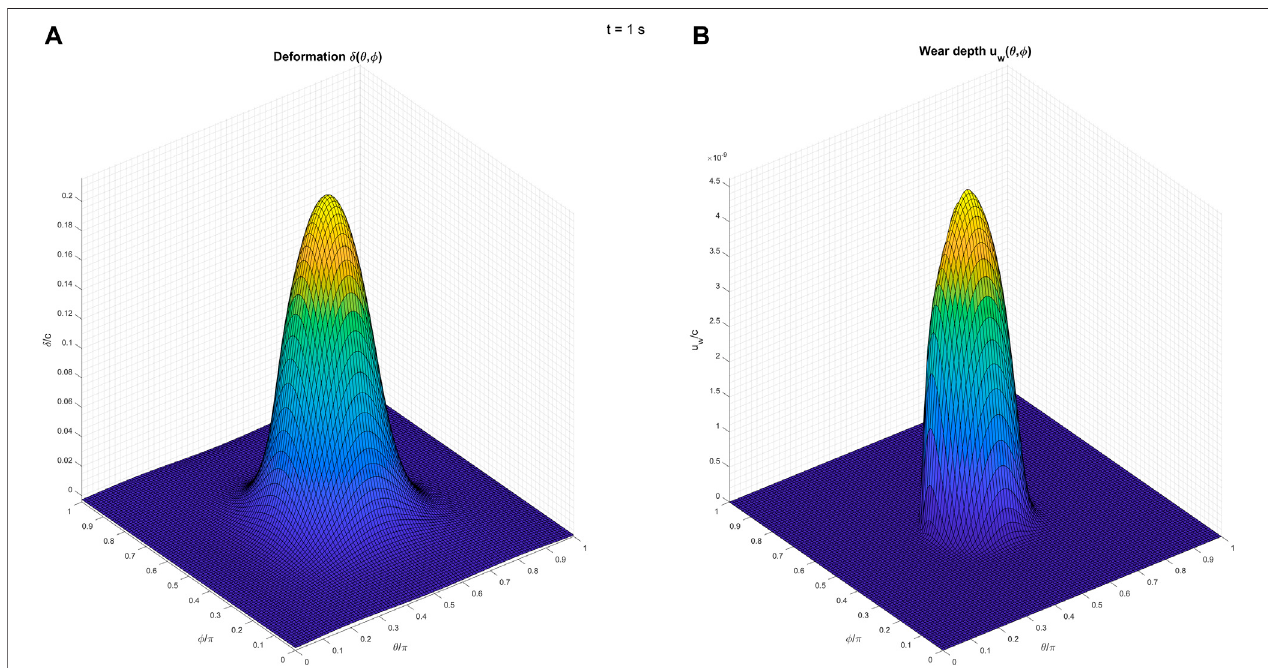
FIGURE 8 | Surface radial deformation (A) and penetration wear depth (B) fi elds.